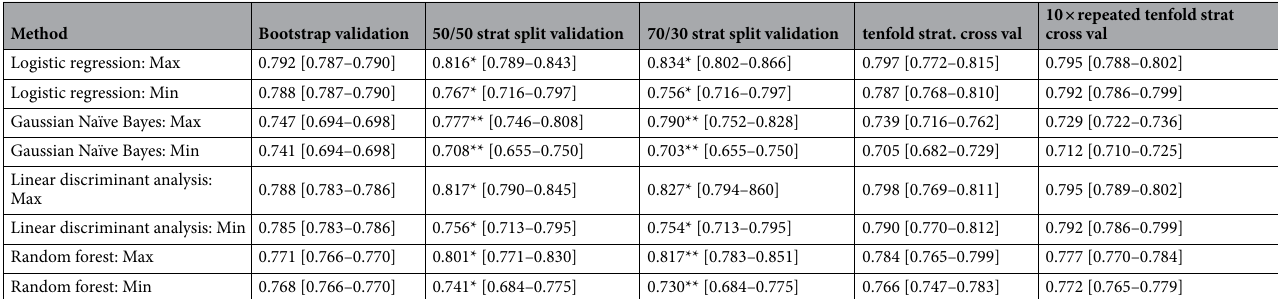
Table 2. 95% AUC estimate/confidence intervals (CI) for maximum and minimum cases (REFINE SPECT). 95% CI calculated using Delong method with concatenated predictions. For bootstrap validation, AUC computed as mean from the AUC of the 500 iterations, sometimes falling out of range of 95% CI. CI calculated using Delong method in brackets. *Signifies measured statistical significance p-value < 0.05 in independent ROC comparison to max–min counterpart for the same algorithm and validation technique. **Indicates p-value < 0.01 in independent ROC comparison. ROC receiver operating characteristic curve, AUC area under the ROC